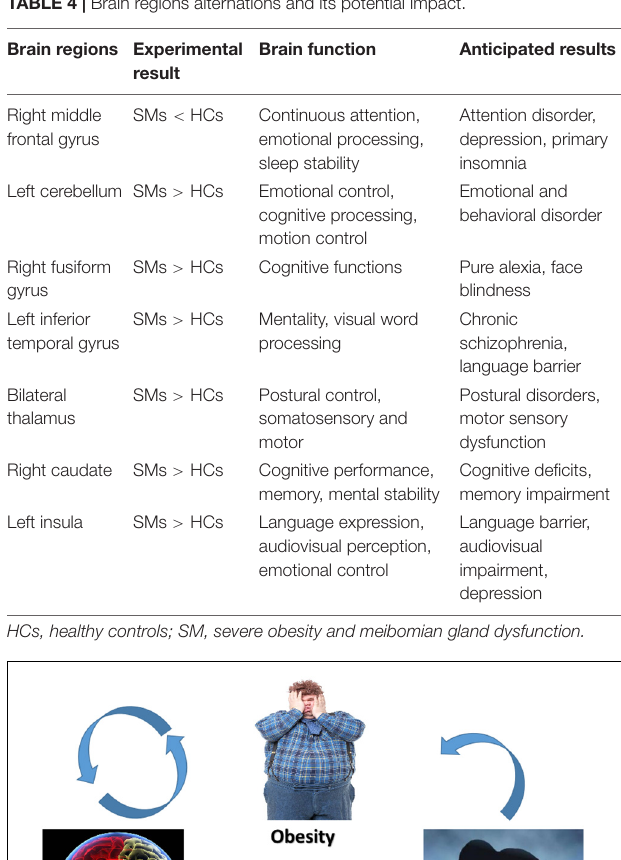
TABLE 4 | Brain regions alternations and its potential impact.